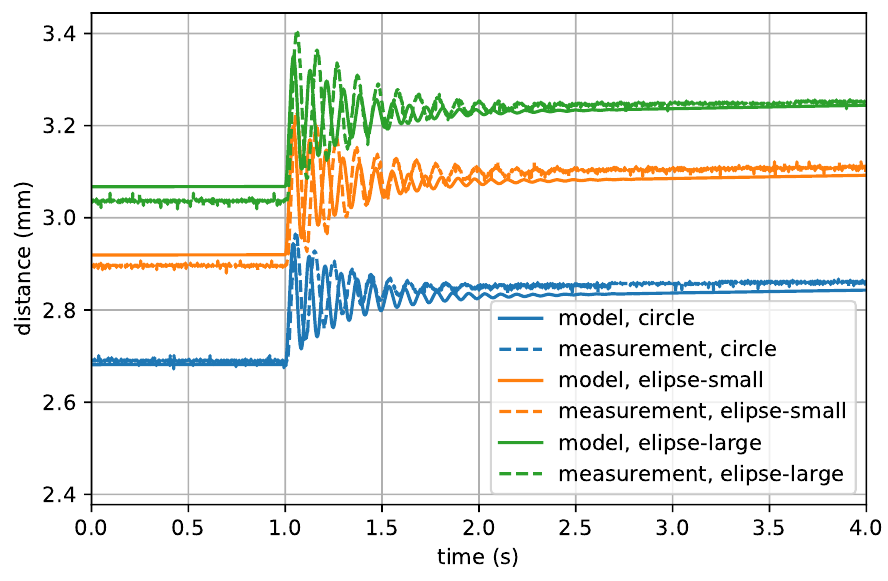
Figure 12. Response of the DEAP actuator for a step voltage signal from 0kV to 3.5kV with a load of 22.45g (zoom version).